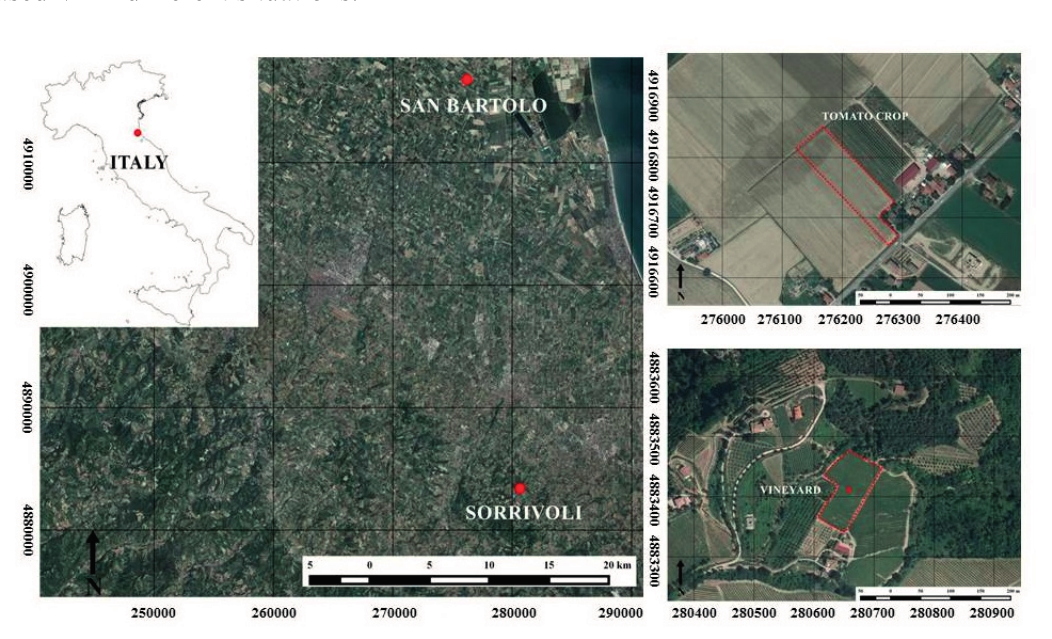
Figure 1. Geographic location of the study areas. The red dot (on the left) and the dashed polygons (on the right, with an equal red dot inside) represent the study areas. Coordinates are referred to UTM, zone 33N